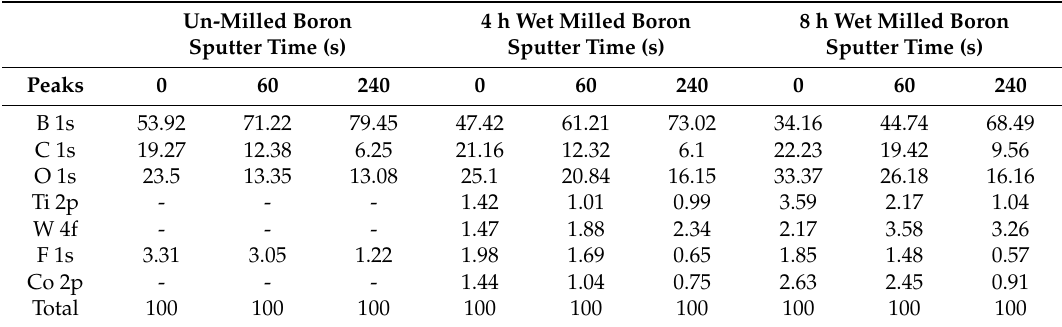
Table 2. Summary of surface atomic compositions of the un-milled and wet milled boron particles at various sputtering times.